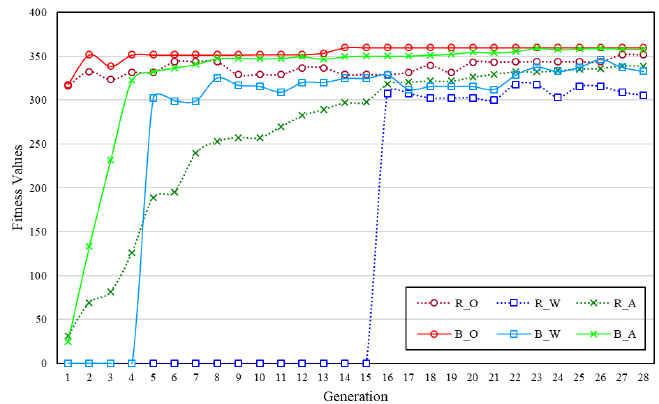
Figure 8. Compare of Roulette Selection and Hybrid Selection.